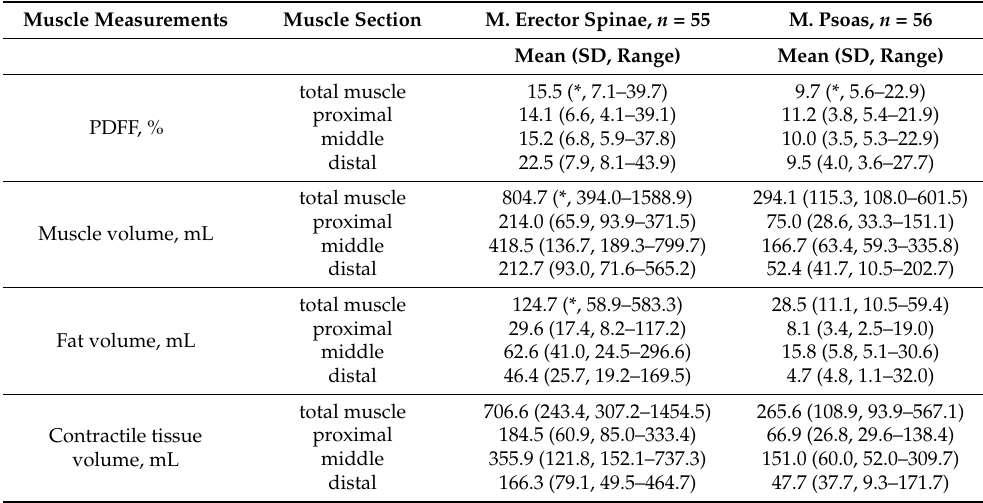
Table 2. Skeletal muscle measurements at baseline for total psoas and erector spinae muscle and for proximal, middle and distal muscle section. PDFF: proton density fat fraction, SD: standard deviation. * no SD due to logarithmic